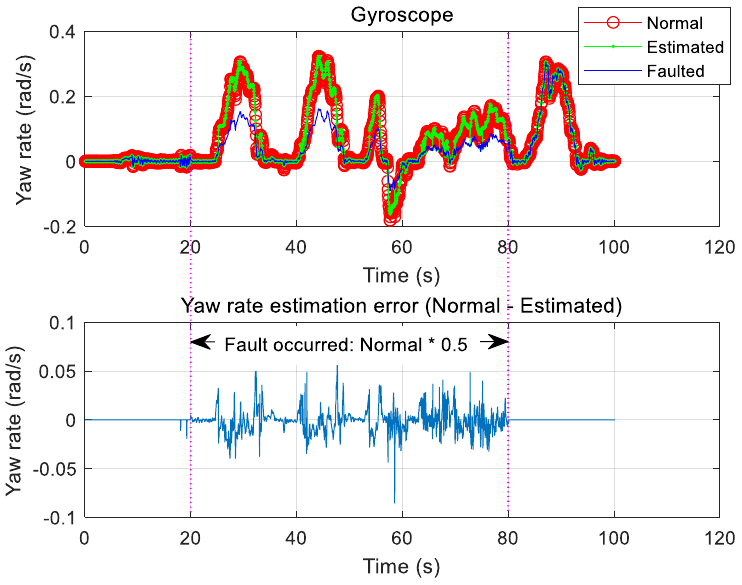
Figure 12. Type 2: Gyroscope fault and estimation.